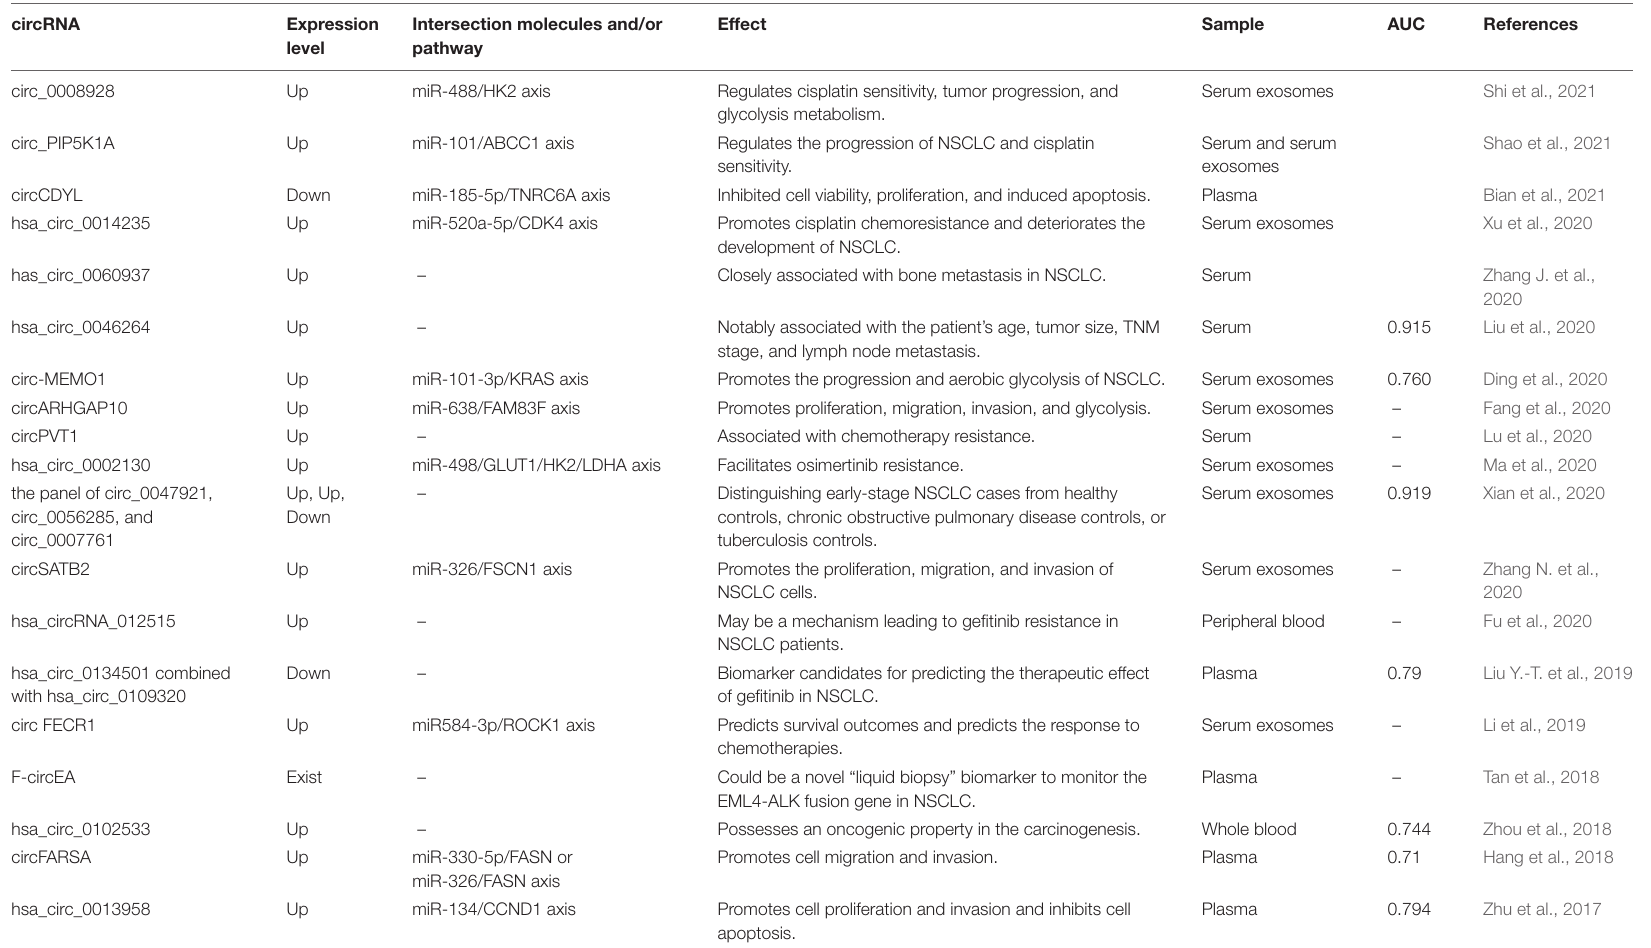
TABLE 1 | circRNAs as biomarkers in liquid biopsy for the diagnosis of NSCLC. circRNA Expression